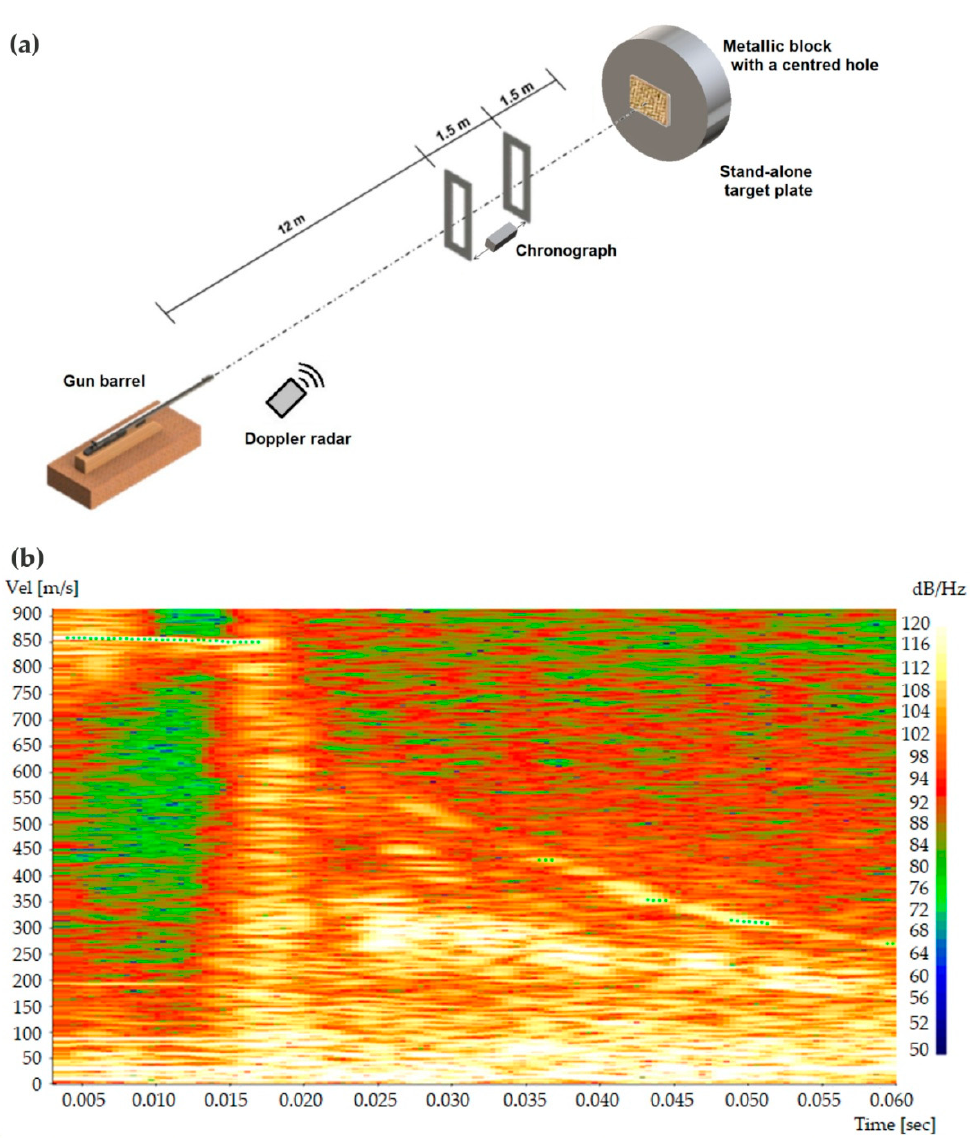
Figure 2. ( a ) Schematic illustration of the CAEx shooting line for stand-alone ballistic test with 7.62 mm ammunition; ( b ) Actual computer-recorded image (radar spectrum) of projectile velocity variation with time also presented.